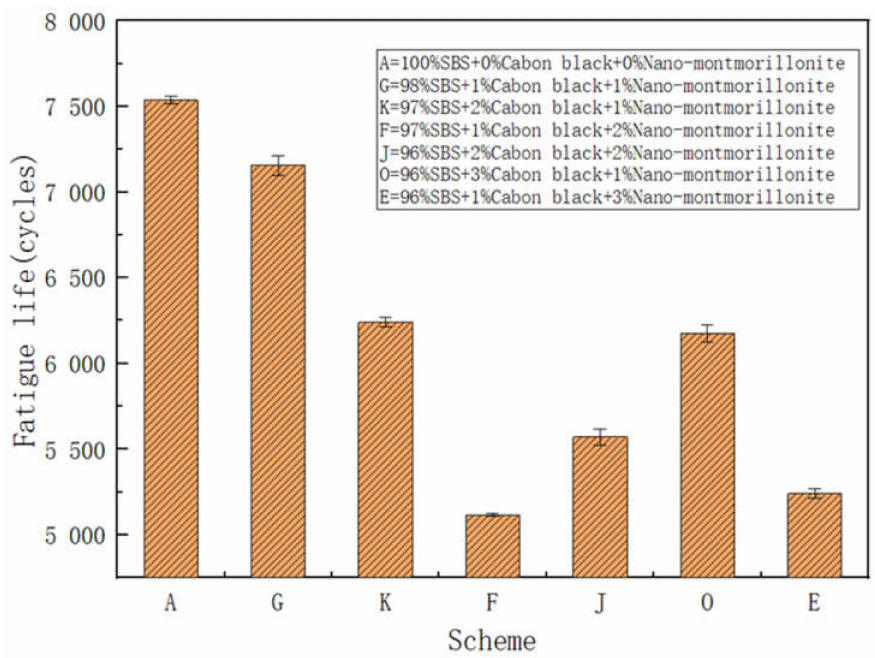
Figure 9. Fatigue life of asphalt from different